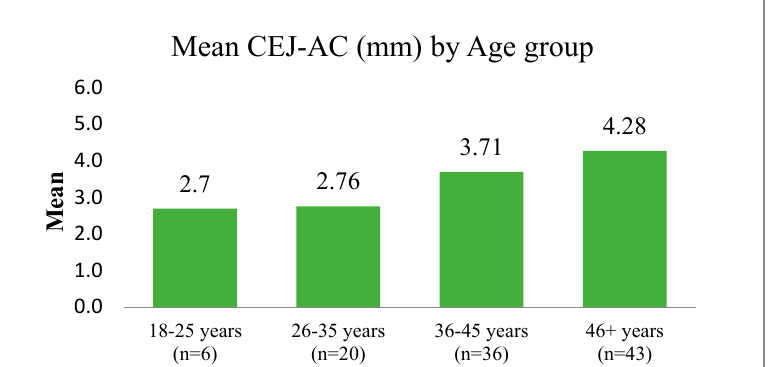
Figure 1. Mean CEJ – AC (mm) (the mean CEJ-AC distance by age group for all teeth (n = 1721)). Figure 1. Mean CEJ–AC (mm) (the mean CEJ-AC distance by age group for all teeth ( n =